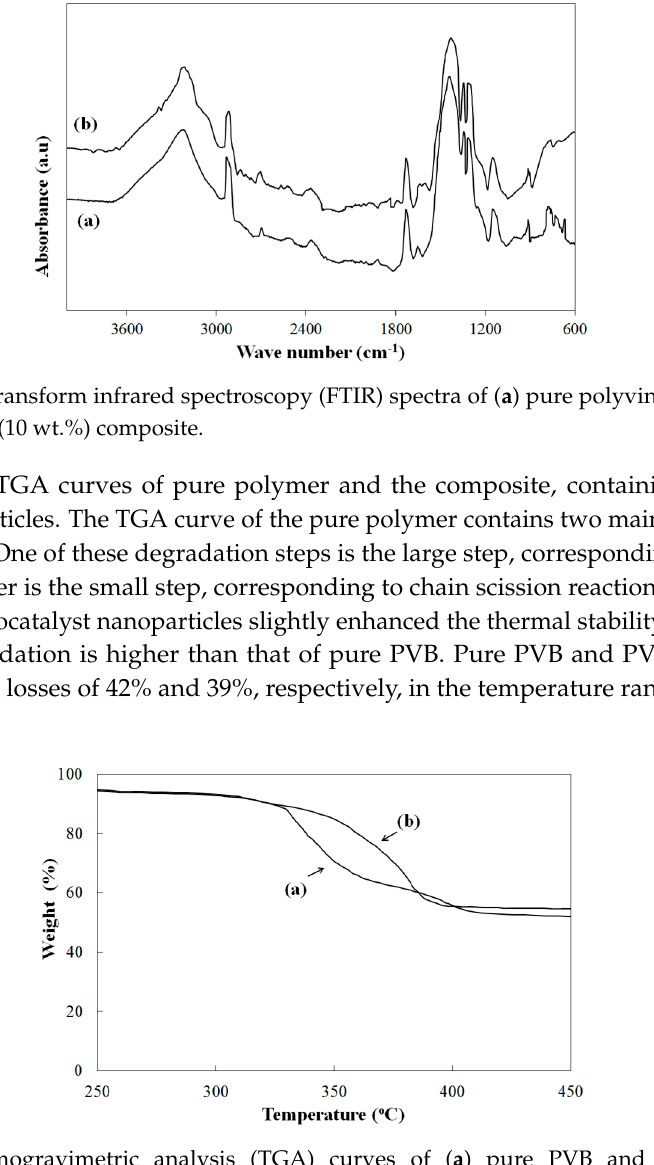
Thermogravimetric analysis (TGA) curves of ( a ) pure PVB and ( b ) PVB/TiO 2 (10 wt.%) composite.